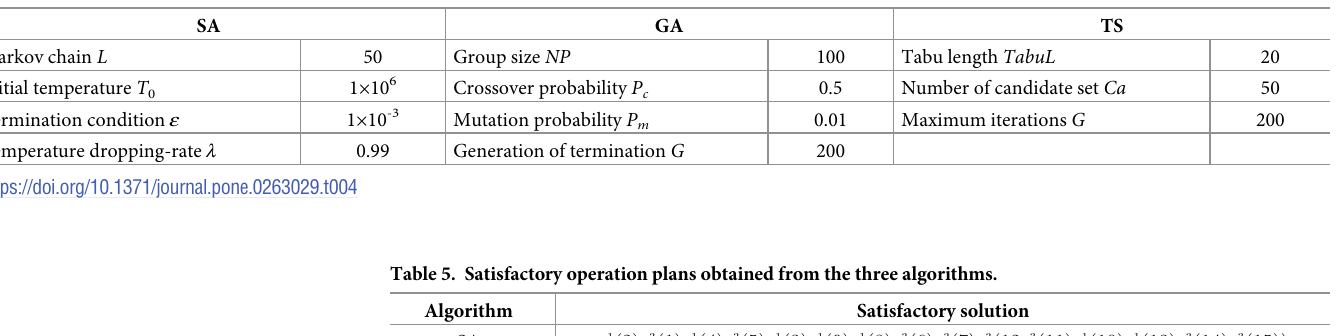
Table 4. Parameters of the three algorithms.